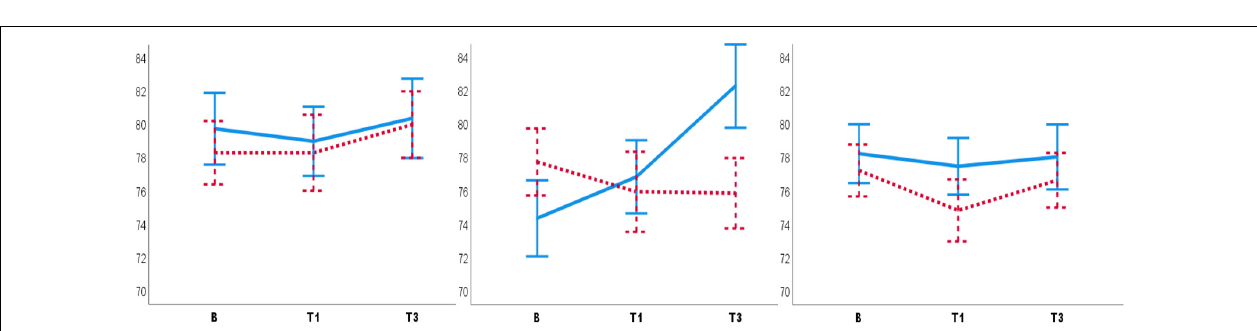
FIGURE 2 | Diastolic blood pressure for males (left panel) and females (right panel) . Male participants had lower DBP in the PC T3 compared to the NHC T3 (left panel) . No such placebo response was observed for females (right panel) . B, baseline. T1, pre-test. T3, post-test. Blue lines: NHC ( N = 30). Red dashed lines: PC ( N = 29). Error bars: ± 1 SE .